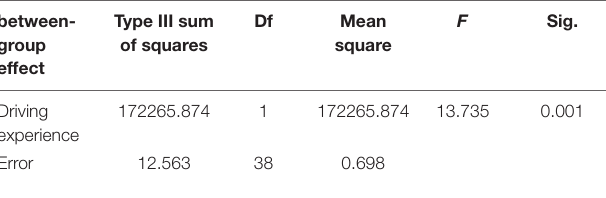
TABLE 11 | The test results of driving experience factor’s main